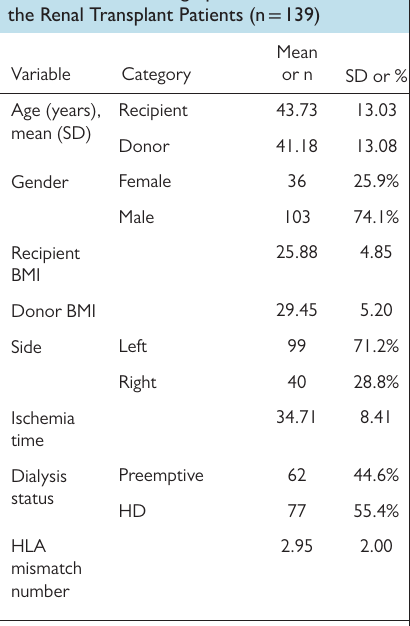
Table 1. Sociodemographic Characteristics of the Renal Transplant Patients (n =